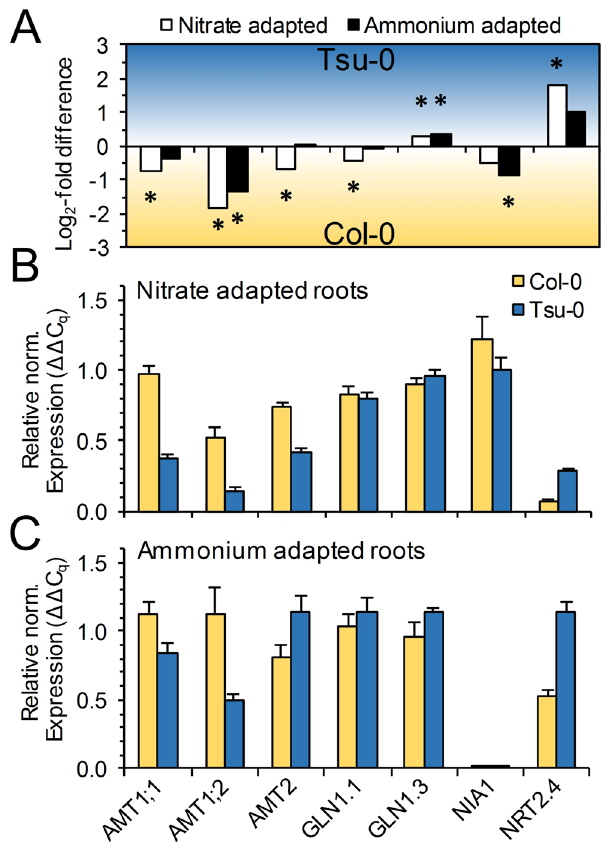
Figure 6. N-related genes which were significantly differentially expressed between Tsu-0 and Col-0 and their validation by qRT-PCR. ( A ) Significantly differentially expressed N-related genes derived from the transcriptome analysis. Negative Log 2 -fold values indicate a higher expression in Col-0 while positive Log 2 - fold values indicate higher expression in Tsu-0. White bars show the comparison of nitrate adapted, black the comparison of ammonium adapted plants. ( B , C ) Show qPCR verification of the differential expression of N-related genes in nitrate-adapted plants ( B ) and ammonium-adapted plants ( C